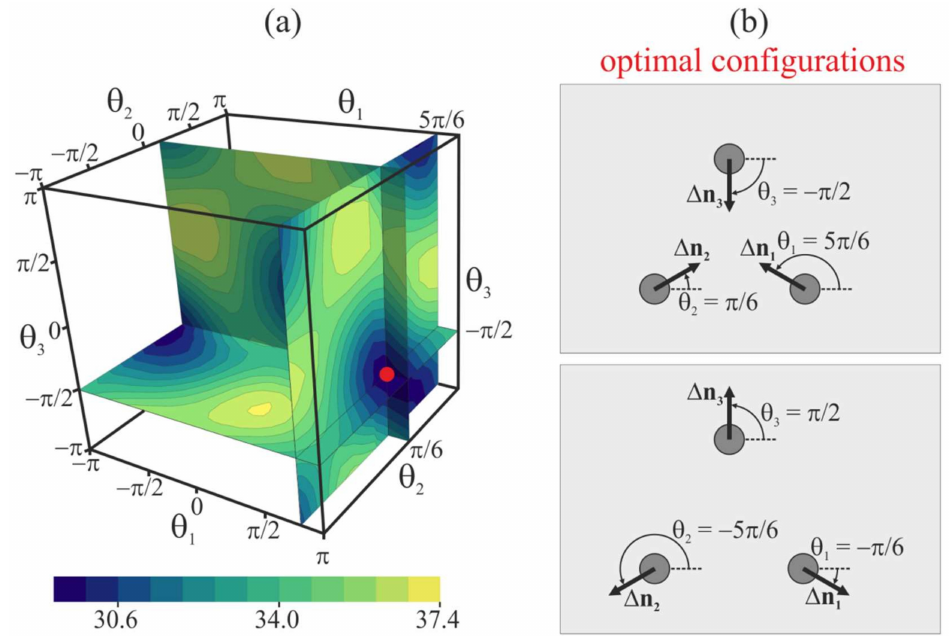
Figure 8. ( a ) Dependence of membrane elastic energy on the orientation angles of three free peptide trimers separated by 10 nm. The minimum of the elastic energy (marked by red circle) is at θ 1 = 5 π / 6, θ = π / 6, θ = − π / 2, and at θ = − π / 6, θ = − 5 π / 6, θ = π / 2. ( b ) Top view of optimal configurations of 2 3 1 2 3 the